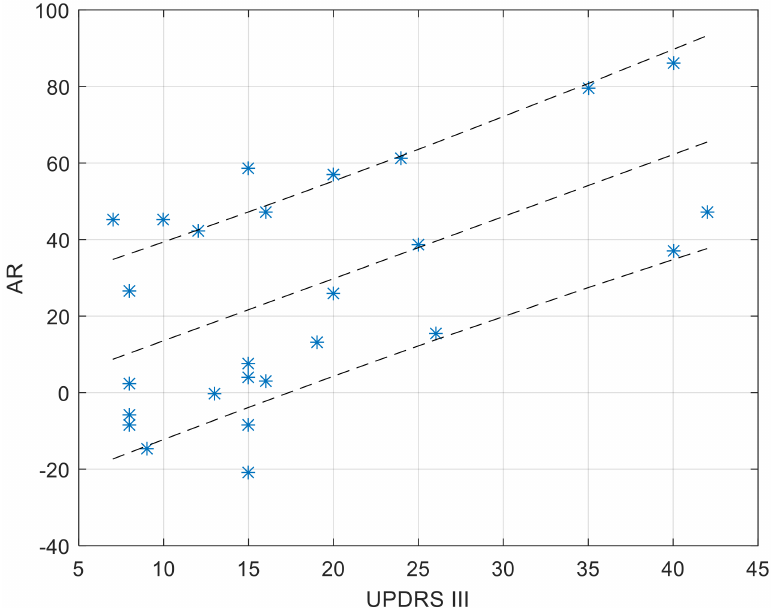
Figure 5. Values of AR_couple_PH as a function of the UPDRS score of the dyad component with PD. The regression function is completed by its 95% confidence interval. A positive AR value (up to a max of 100%) denotes larger values in the MA profile of the healthy dyad